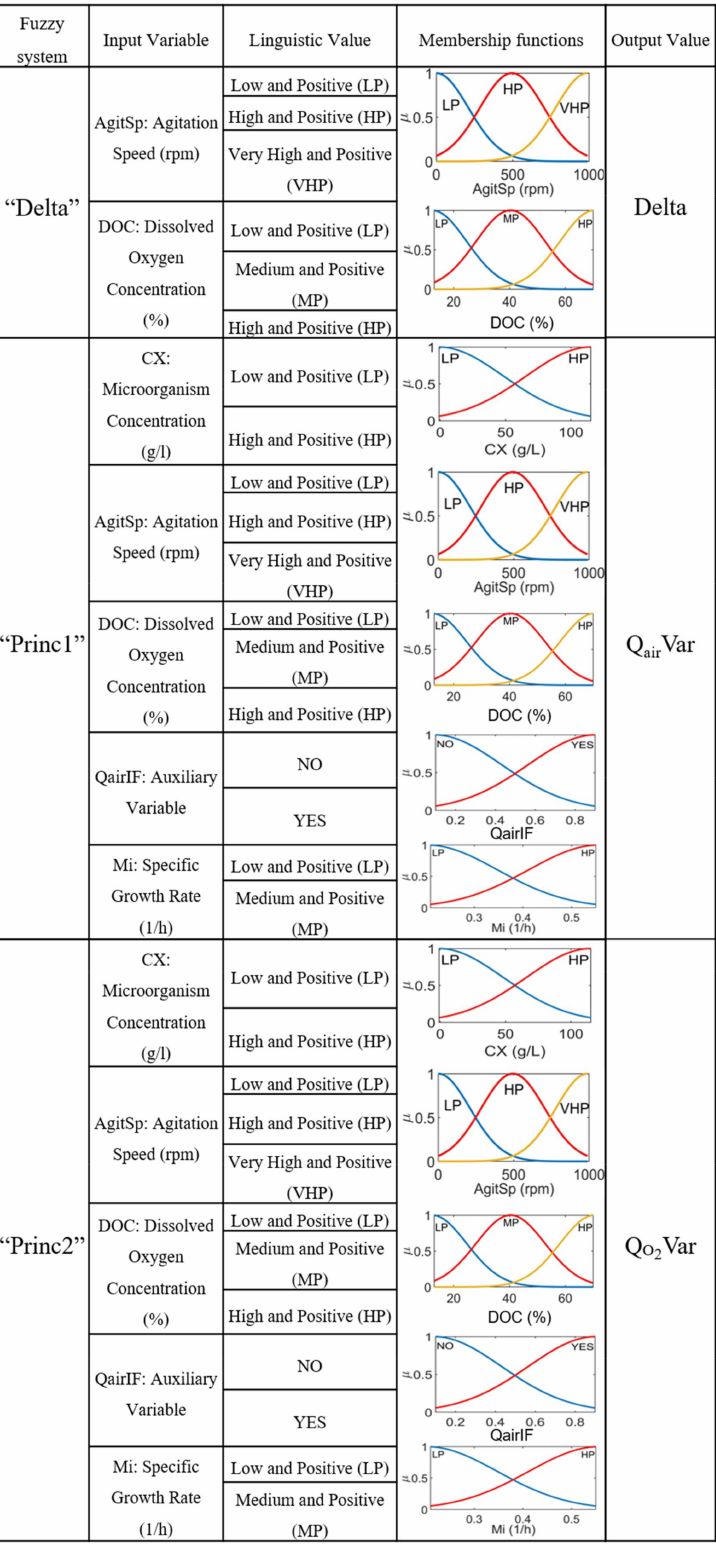
Figure 3. Delta, Princ1, and Princ2 Sugeno-type fuzzy inference systems input variables (with their linguistic values and membership functions) adjusted by